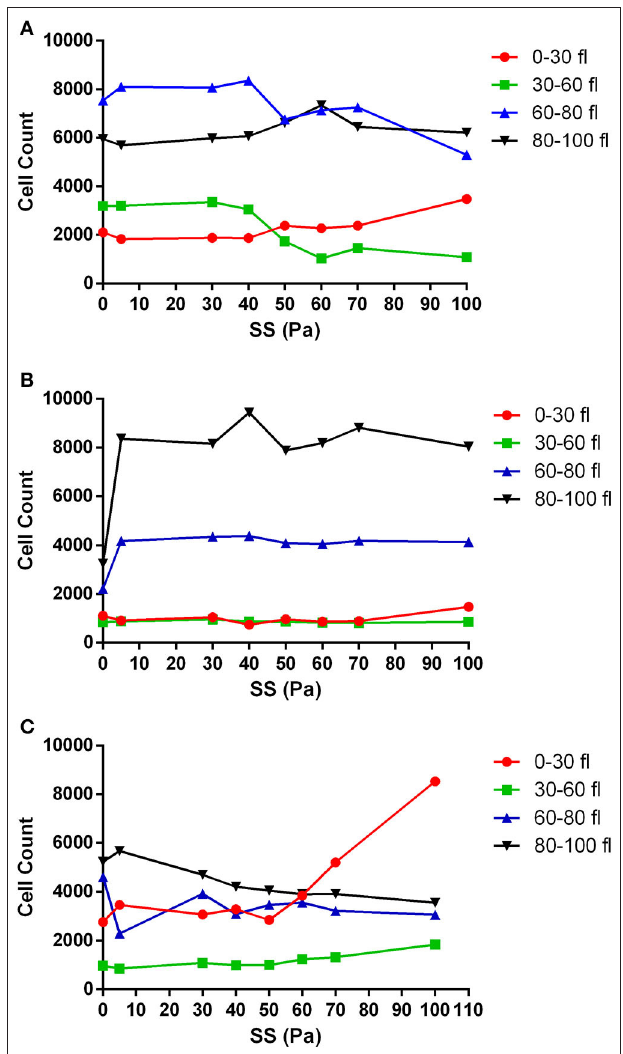
FIGURE 4 | The change in the number of RBCs with applied SS in different volume ranges. (A) Healthy control RBCs, (B) metabolically depleted RBCs, and (C) oxidatively damaged RBCs. n = 5. 0–30 fl, 30–60 fl, 60–80 fl, and 80–100 fl ranges represent fragmented cells, smaller cells, normal cells, and larger cells, respectively. Significant differences are provided in Supplementary Table 2